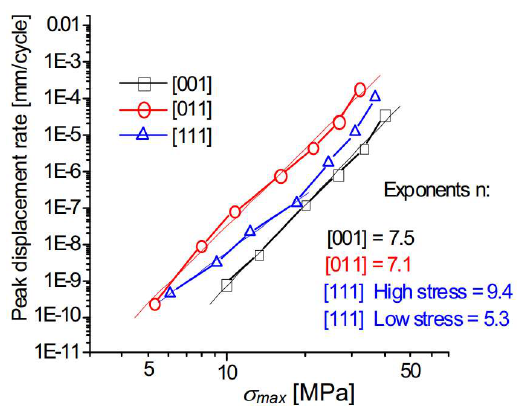
Figure 16. Peak displacement rates in the second stage of damage accumulation as a function of σ max .